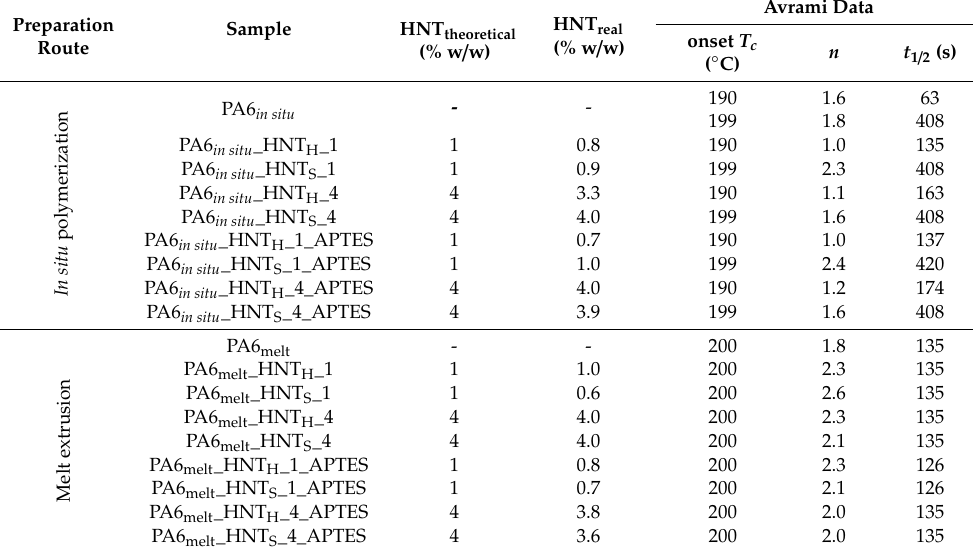
Table 2. PA6 nanocomposites prepared via in situ polymerization and melt blending processes: theoretical and actual loading from TGA analyses, and kinetic analysis of isothermal crystallization data obtained via Avrami